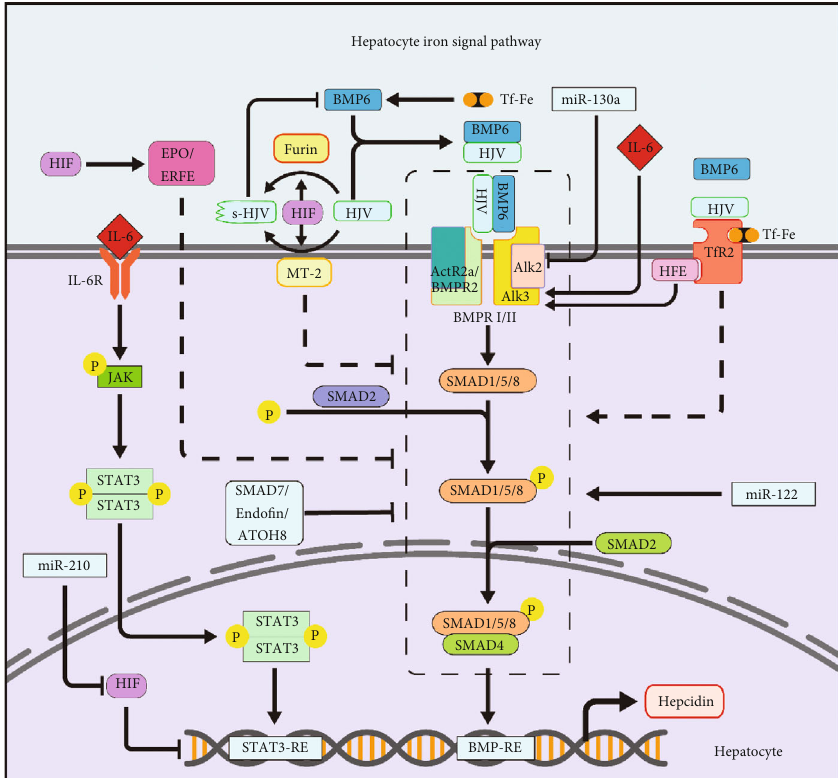
Figure 2: Hepatocyte pathways regulate iron